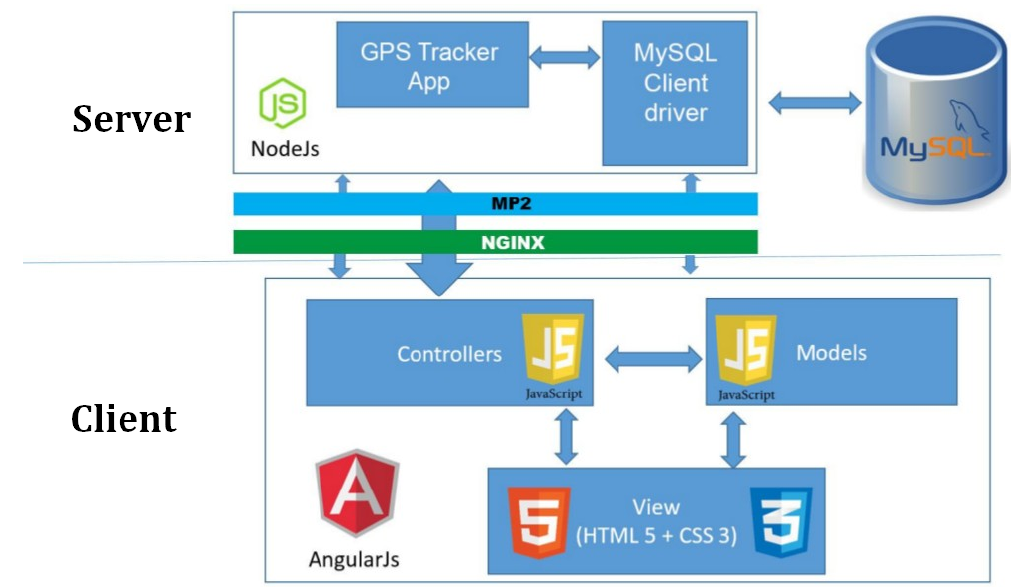
Figure 2. Client/server architecture of the whole tracking framework.